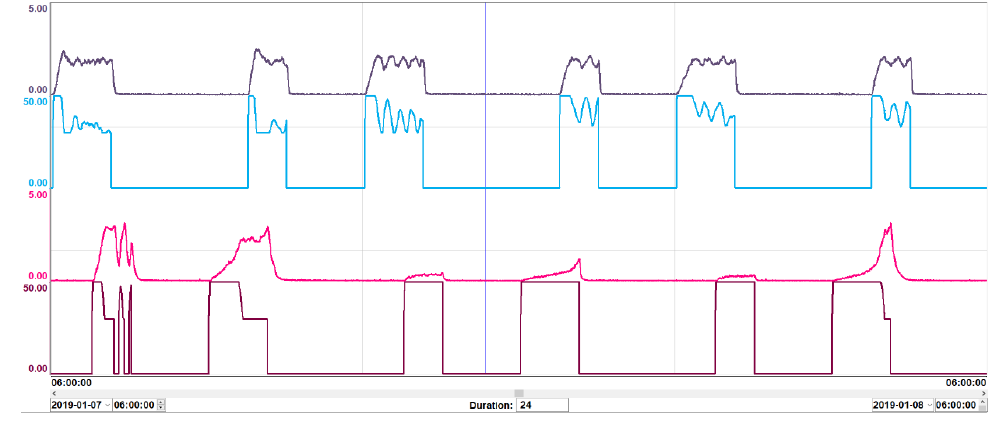
Figure 3. Historical data of dissolved oxygen (DO) [mg O 2 /l] control [15].